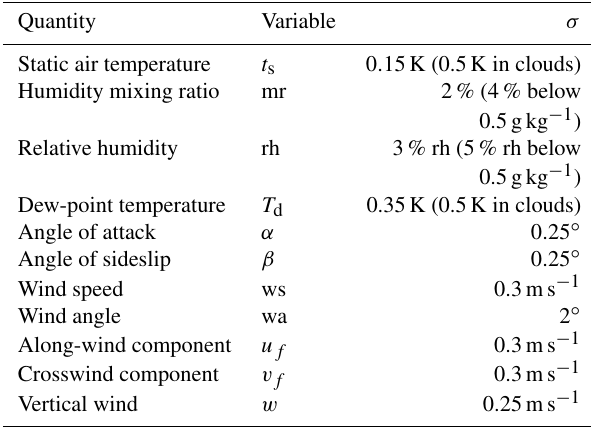
Table 1. List of the measurement uncertainties for the main mete- orological parameters of the sensors flown on the Caravan research aircraft. Results from Mallaun and Giez